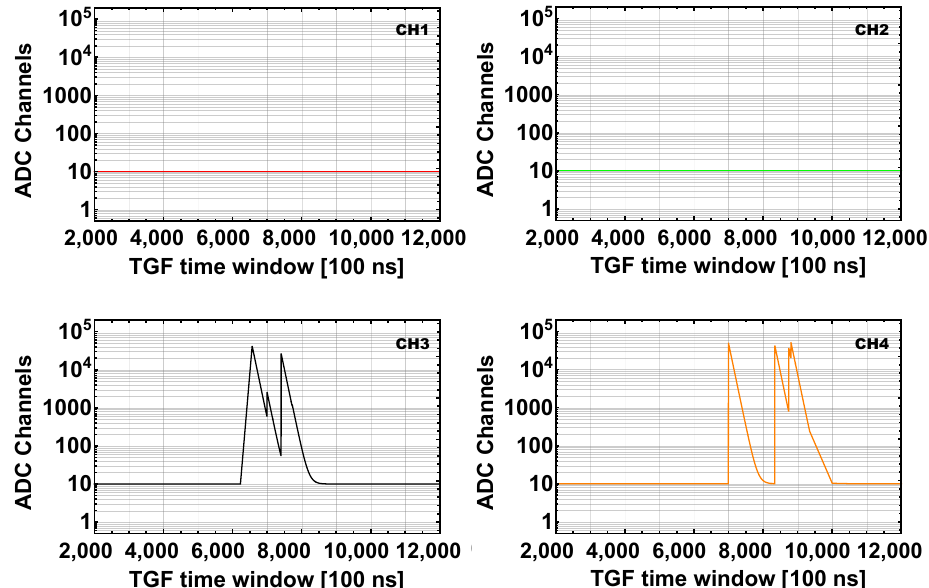
Figure 17. The event seen at the level of the readout electronics in 1 ms time window. The two chan- nels on top (namely, CH1 and CH2) did not detect events, while the peaks visible in the CH3 and CH4 correspond to gamma-rays detected in a 175 µ s time range. The red star indicates the simultaneous detection of gamma-rays in both channels due to a Compton